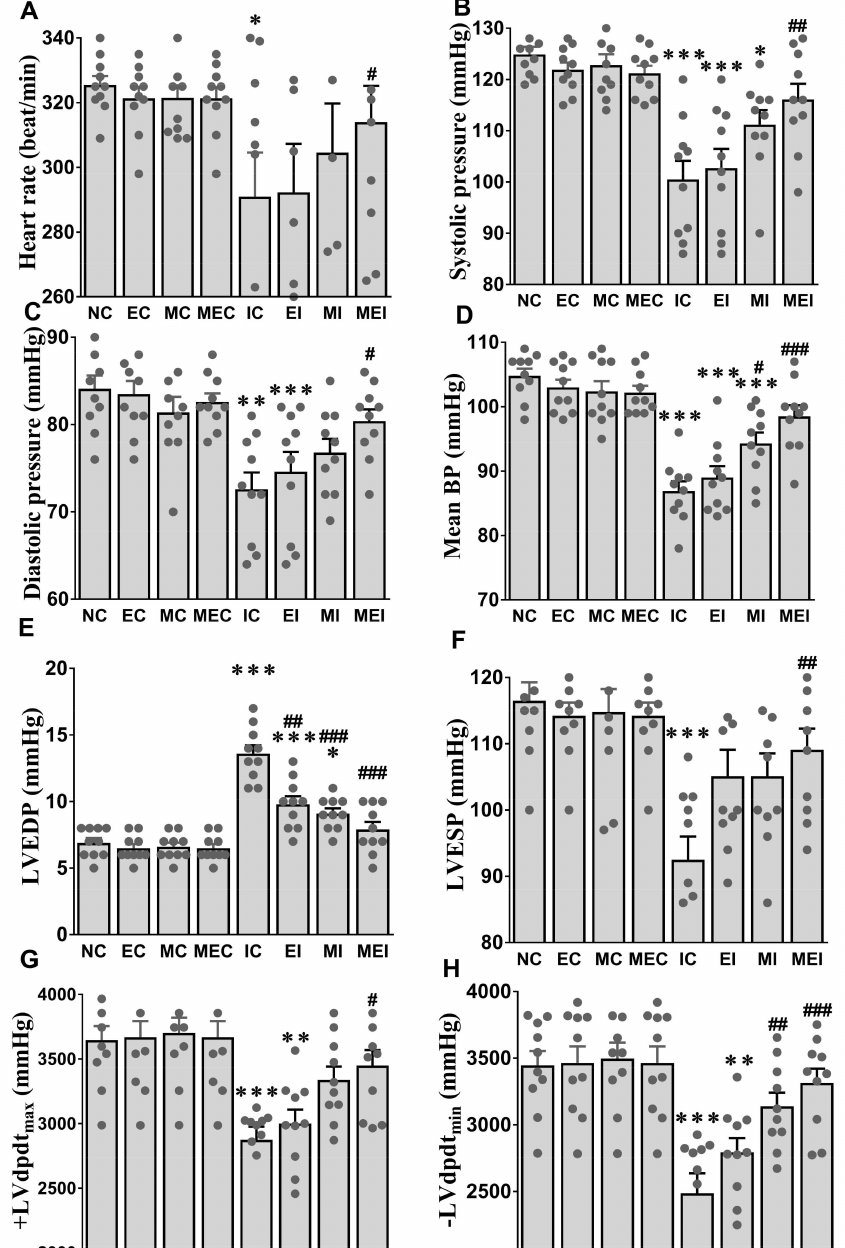
Figure 1. Effect of melatonin and exercise on cardiac contractile function in isoproterenol-challenged rats. ( A ) Heart rate; ( B ) Systolic pressure; ( C ) Diastolic pressure; ( D ) Mean blood pressure; ( E ) LVEDP, left ventricular end-diastolic pressure; ( F ) LVESP, left ventricular end-systolic pressure; ( G ) LVdpdt max , maximum left ventricular developed pressure; ( H ) LVdpdt min , minimum left ventric- ular developed pressure. The data are reported as the mean ± SEM ( n = 10). * p < 0.05, ** p < 0.01, and *** p < 0.001 versus the NC group; # p < 0.05, ## p < 0.01, and ### p < 0.001 versus the IC group calculated through one-way ANOVA followed by the post hoc Bonferroni test. NC, normal control; EC, exercise control group; MC, melatonin control group; MEC, melatonin plus exercise control group; IC, isoproterenol control group; EI, exercise plus isoproterenol-challenged group; MI, melatonin plus isoproterenol-challenged group; MEI, melatonin and exercise plus isoproterenol-challenged